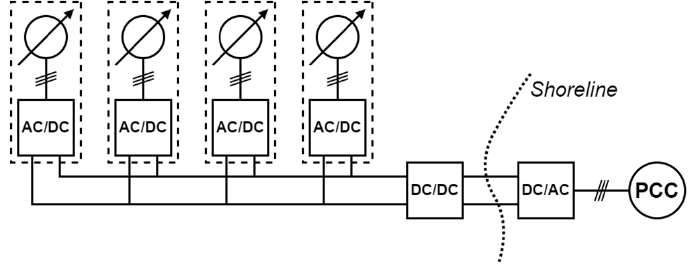
Figure 21. Topology T3. A parallel-connected DC collection grid with rectification in the marine energy converters and DC/DC conversion in a central offshore hub.